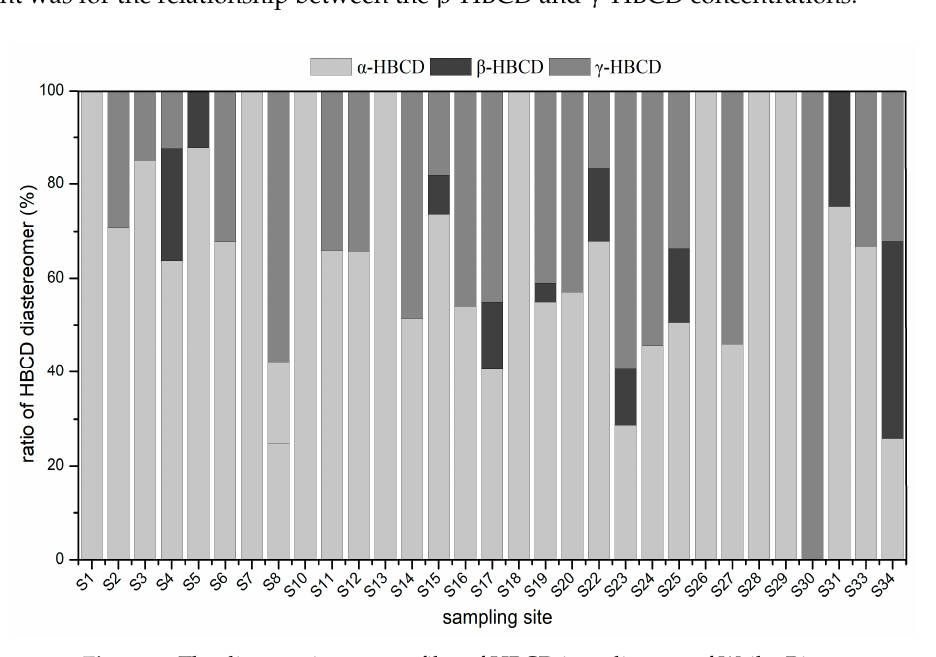
Figure 3. The diastereoisomer profiles of HBCD in sediments of Weihe River. Table 3. Results of Pearson correlation analysis between total organic carbon (TOC) and individual HBCD diastereoisomers, and HBCD in sediment samples.